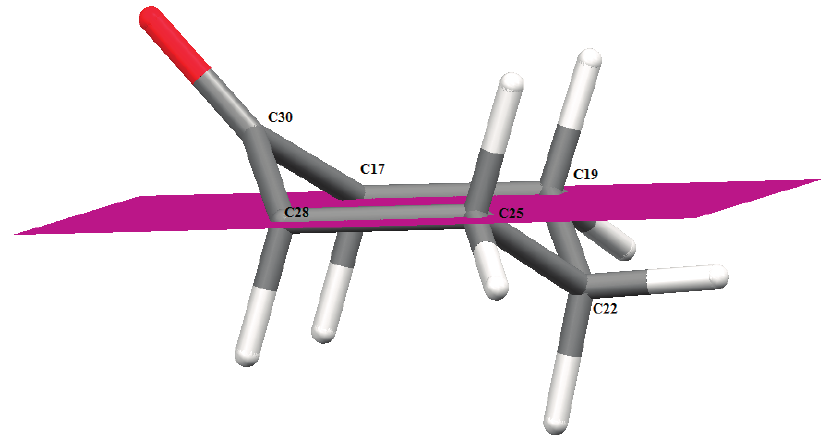
Figure 4. The optimized molecular structure of the studied compound ( upper ) and the chair form configuration of the cyclohexanone ring ( lower ).